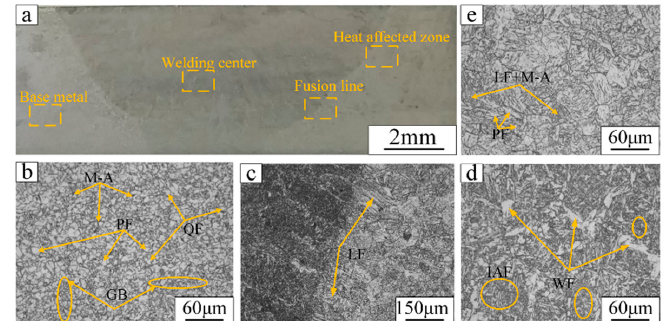
Figure 2. Metallographic structures of X80 steel welded joint without weld reinforcement and root notch. ( a ) The macro morphology of the weld cross section; ( b ) base metal; ( c ) fusion line; ( d ) welding center; ( e ) heat affected